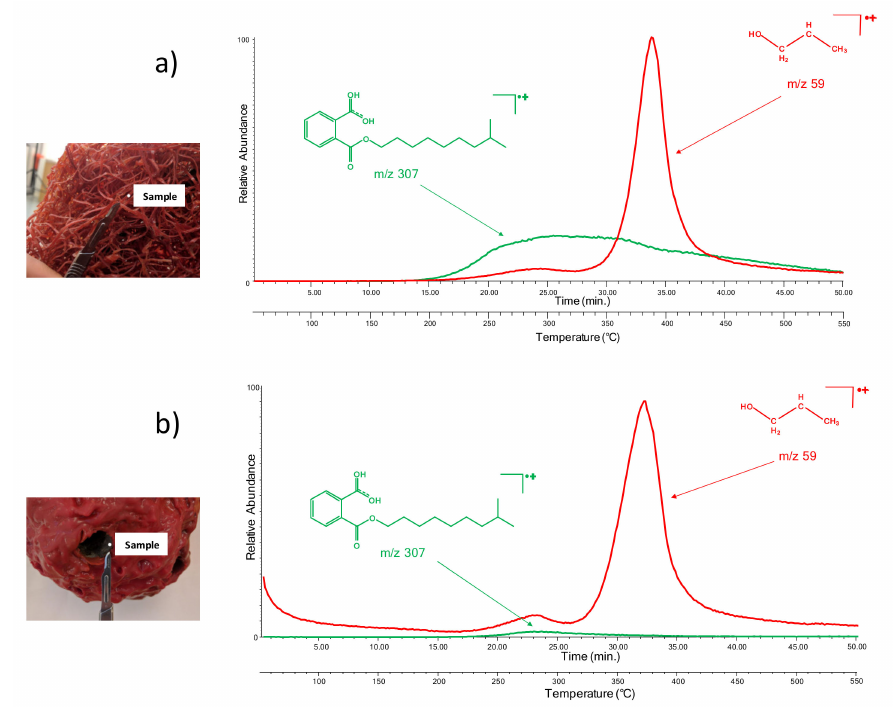
Figure 3. The extracted ion ( m / z 307, 59) thermograms obtained for the sample from “Angel Lamp”: ( a ) the sample from the side of the lamp and ( b ) the sample from the head of the